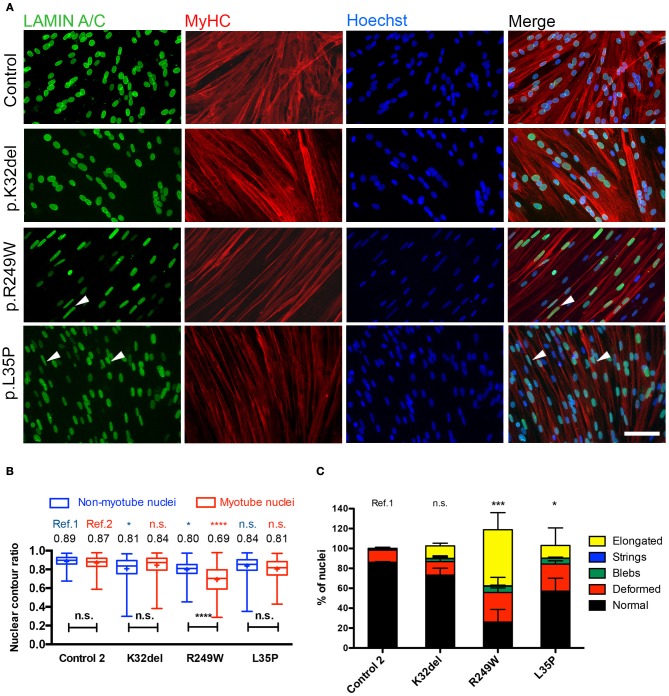
Terminal skeletal myogenic differentiation of LMNA-mutant iPSC-derived myotubes in monolayer culture and analysis of nuclear circularity and shape abnormalities. (A) Representative immunofluorescence for Lamin A/C and Myosin Heavy Chain (MyHC) on K32del, R249W, and L35P iPSCs HIDEMs induced to terminal myogenic differentiation by transient expression of a lentivirally-delivered, tamoxifen-inducible MyoD-ER transgene. Elongated nuclei and nuclear blebbing were visible (arrowheads). Scale bar: 100 μm. (B) Quantification of the average nuclear circularity of terminally differentiated LMNA-mutant iPSCs by measuring the contour ratio of nuclei within myotubes and those outside of myotubes. Refs = control. Data analyzed with two-way repeat measures ANOVA, with Tukey's post-hoc test for comparisons to control, and Sidak's post-hoc comparison for comparisons within each line. n = 3 independent experimental replicates, with 100–270 nuclei analyzed per cell line per repeat, except for one repeat in K32del where only 57 nuclei were found outside of myotubes. *p < 0.05, ****p < 0.0001. Data are box plots with the individual circularity values from all three repeats combined (275–715 nuclei per cell line in total). Whiskers: min and max values; +: average of all values. (C) Quantification of the prevalence of myonuclear shape abnormalities based on criteria established in HIDEMs (Figure 2). When present, nuclei with more than one type of abnormality were scored twice (e.g., blebs and elongated), so totals exceed 100%. The number of normally shaped nuclei was compared between LMNA-mutant HIDEMs and control 2 (ref). Between 78 and 348 nuclei were analyzed per cell line per repeat (a total of 260–710 nuclei were assessed per cell line). Statistics were performed on the average values of the three repeats (n = 3) compared to each control line, using one-way analysis of co-variance (ANOVA) with Tukey's post-hoc comparisons; *p < 0.05, ***p < 0.001.